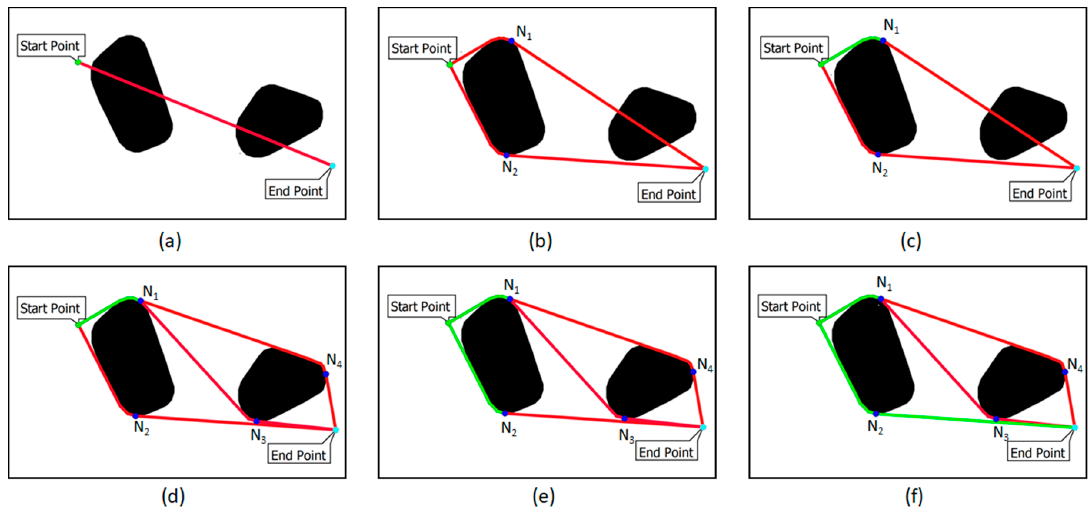
Figure 14. Strategic deconfliction around NFZ and PPZ objects depicted in 2D plan view; ( a ) direct line from start to end point is tested—test fails due to first NFZ object; ( b ) two alternative paths are proposed to lead around the NFZ; ( c ) upper path is shortest and tested next, edge from start point to node N 1 is confirmed and edge from N 1 to end point fails due to PPZ object; ( d ) two alternative paths, connecting N 1 to end point, are proposed to lead around PPZ; ( e ) of the three paths, the lower one is the shortest and is tested next—edge from start point to node N 2 is confirmed; ( f ) edge from N 2 to end point is confirmed, thus confirming the entire path.